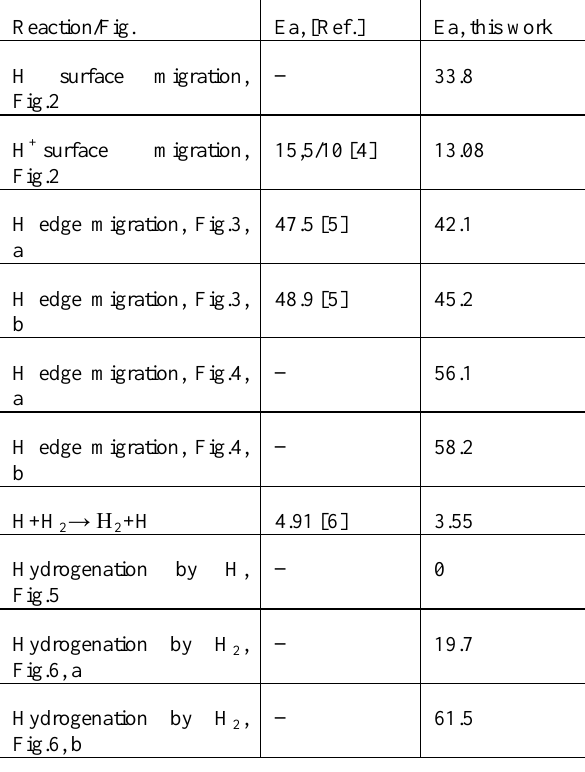
Table 1. Activation energies of reactions (in kcal/mol) Reaction/Fig. Ea, [Ref.]